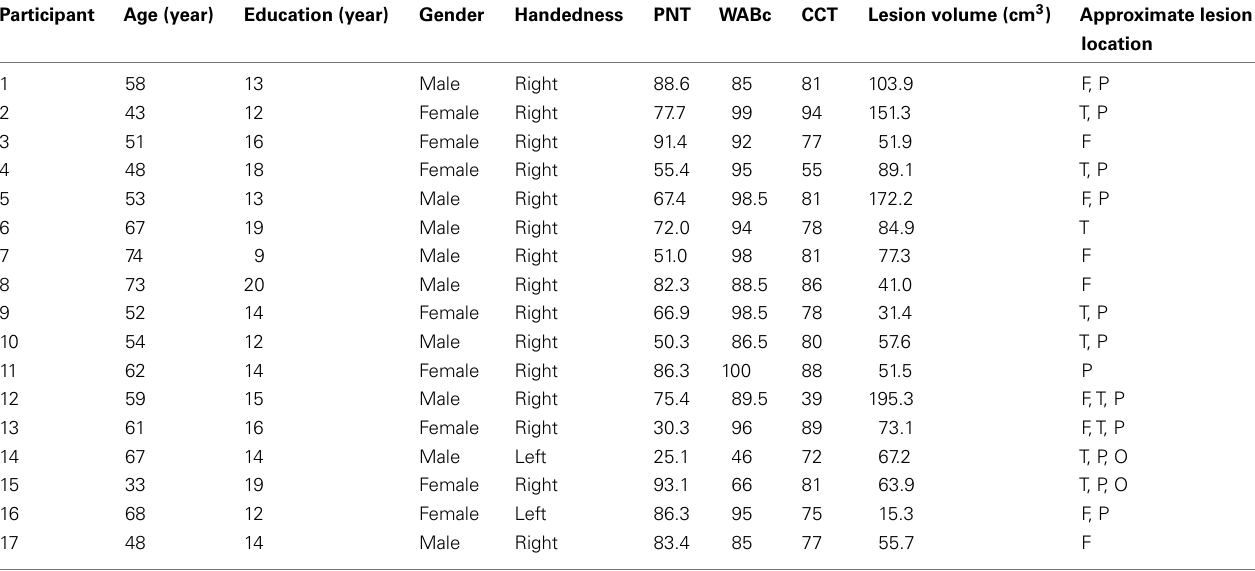
Table 1 | Demographic, neuropsychological, and lesion data from the 17 stroke